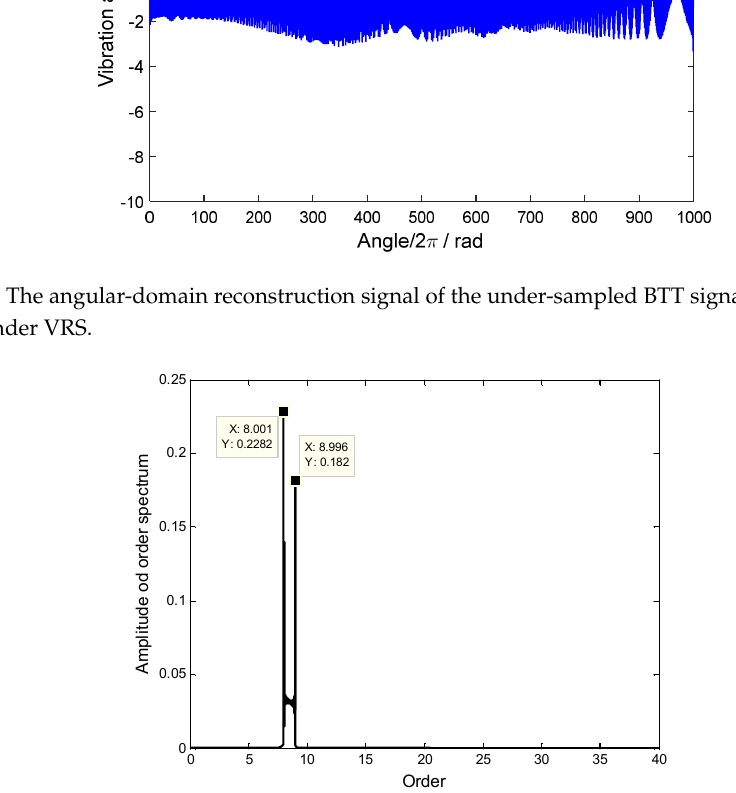
Figure 15. Order spectrum of the angular-domain reconstruction signal using two non-uniform BTT sensors under VRS.